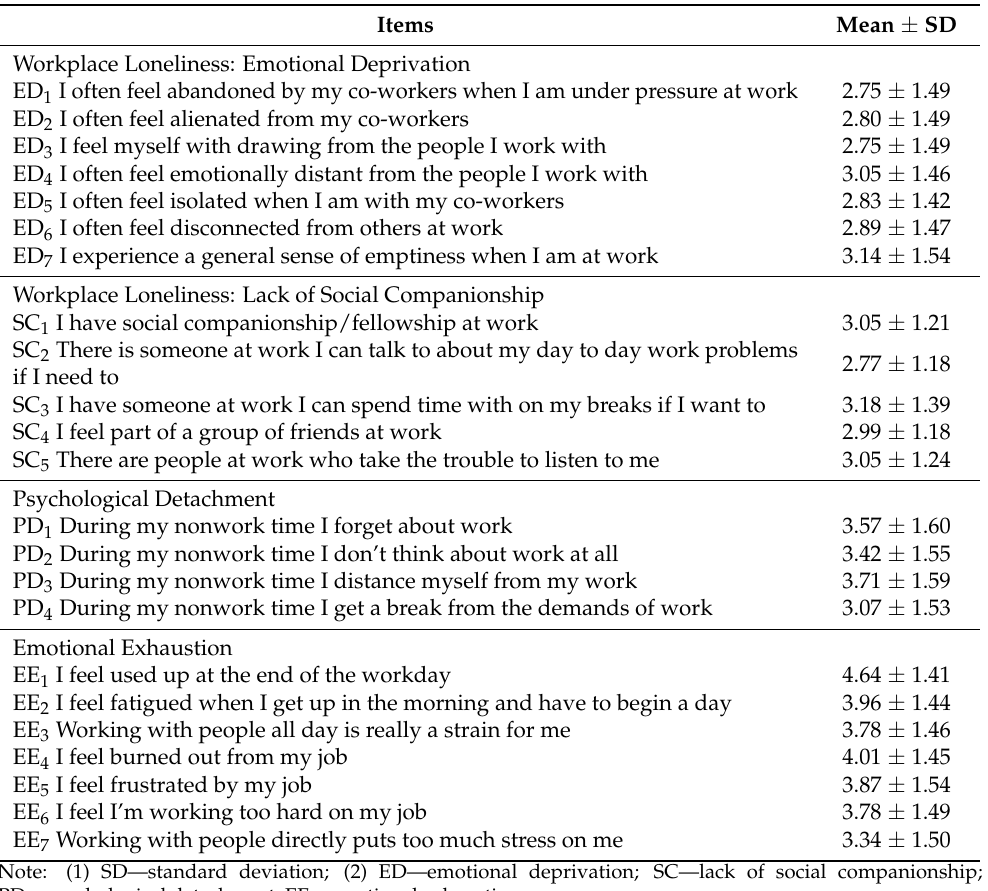
Table 1. Descriptive statistics of